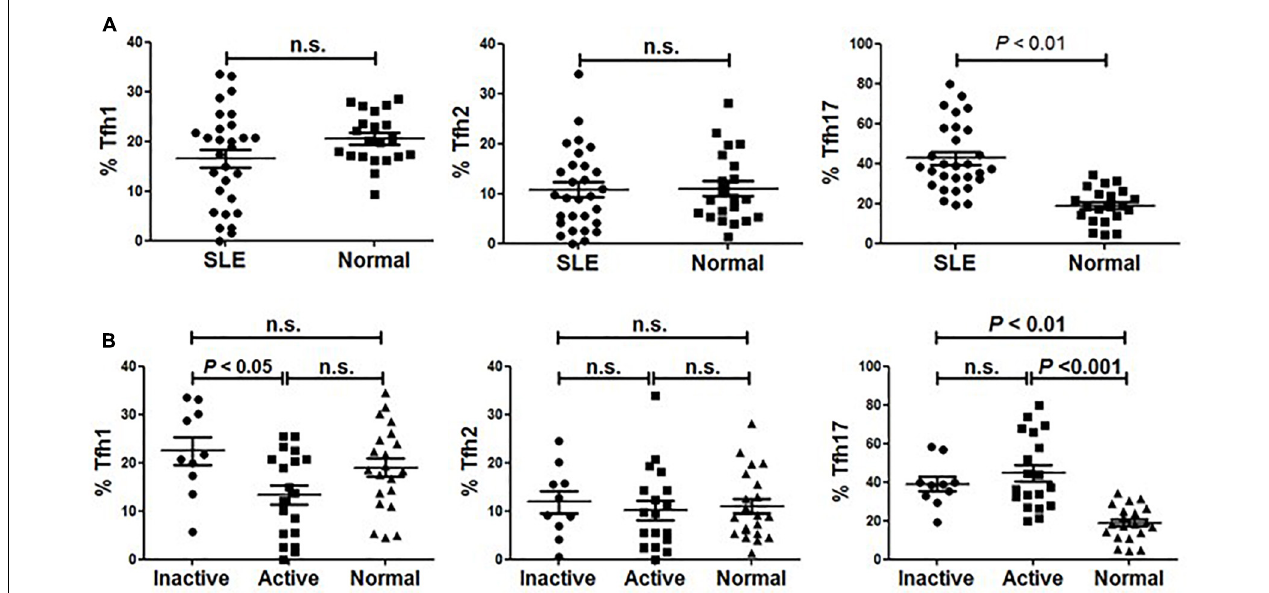
FIGURE 2 | Abnormal distribution of Tfh1 and Tfh17 cells in active SLE patients. (A) Frequencies of Tfh1, Tfh2 and Tfh17 cells were analyzed and compared between SLE patients and healthy controls. (B) Frequencies of Tfh1, Tfh2 and Tfh17 cells were analyzed and compared between inactive SLE patients, inactive SLE patients and healthy controls. All results are presented as mean ± standard error of the mean (SEM). n.s., not